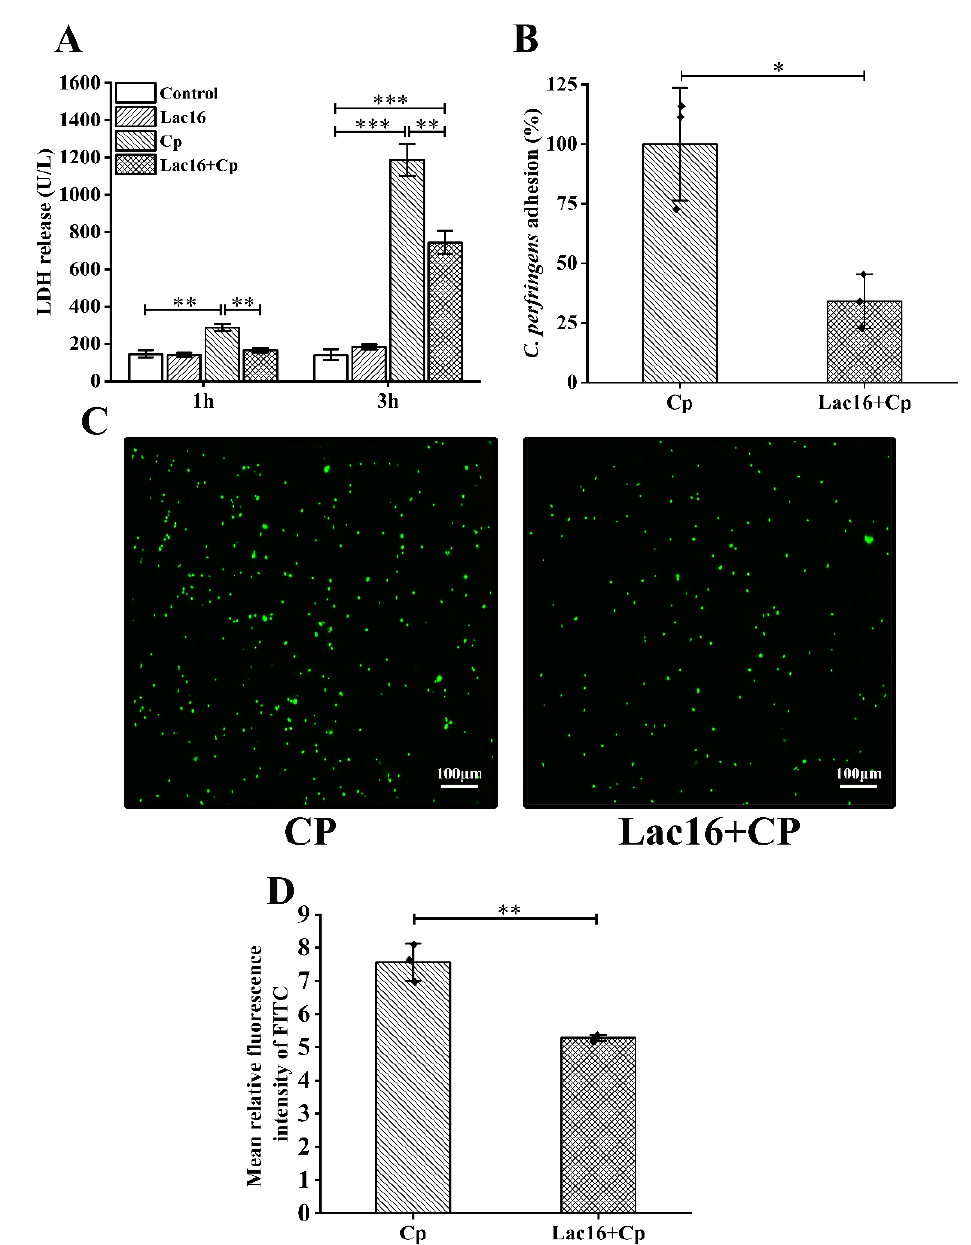
Figure 3. Cytotoxicity and C. perfringens adhesion assays. ( A ) Concentrations of LDH in the super- natants of IPEC-J2 cells. ( B ) Adhesions of C. perfringens to IPEC-J2 cells were detected by tryptose sulfite cycloserine (TSC) agar. Adherence ratio of the C. perfringens group was normalized to 100%. ( C ) Adhesions of C. perfringens (green) to IPEC-J2 cells were detected by fluorescence labeling method. ( D ) The mean relative fluorescence intensity of fluorescein isothiocyanate (FITC) in panel C. Data are presented as the means ± SD for n = 3; * p < 0.05, ** p < 0.01, *** p < 0.001 ( t test).